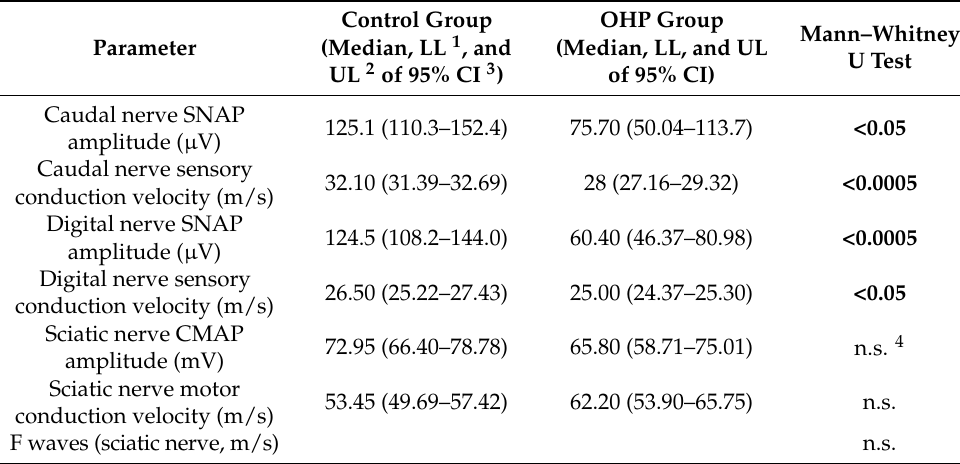
Table 1. NCS values after treatment completion and Mann–Whitney U test results.